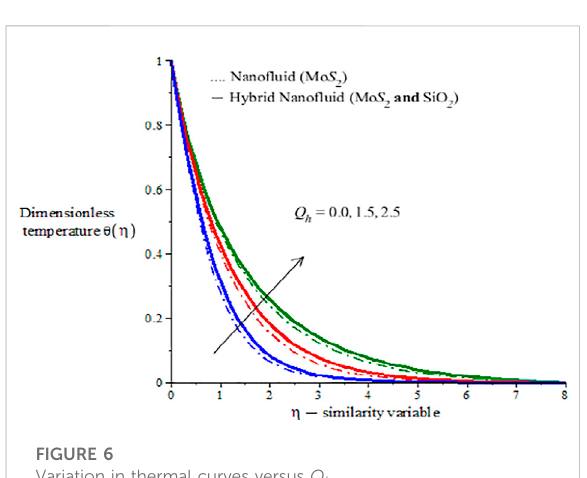
FIGURE 6 Variation in thermal curves versus Q h .